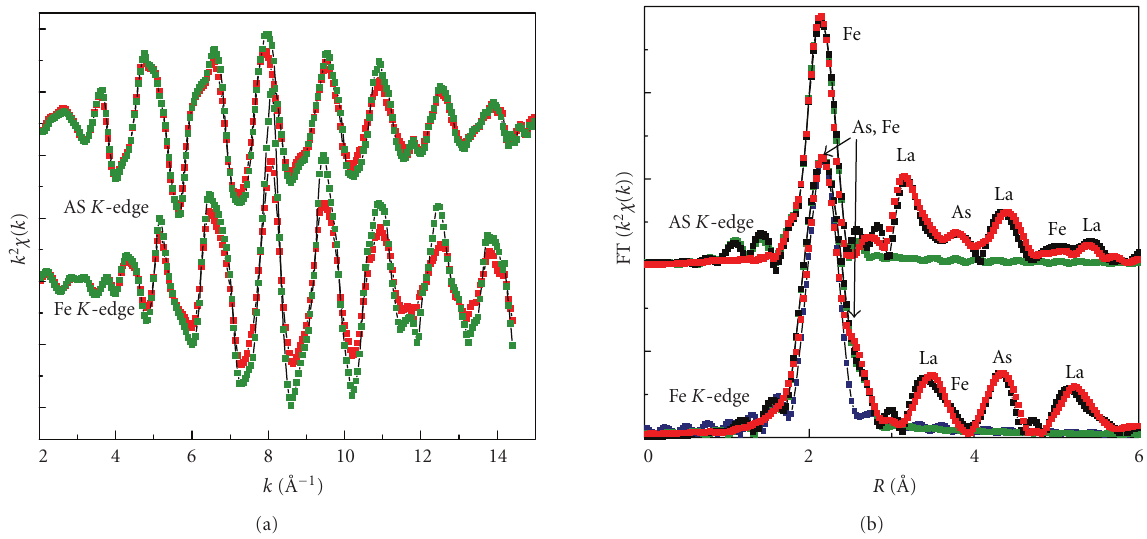
Figure 2: (a) The Fe K - and As K -edge EXAFS oscillations for LaFeAsO 1 − x F x ( x = 0 . 07) plotted as a function of photoelectron wave number k . Red and green marks indicate the data measured at 300 K and 10K, respectively, with a fluorescence detection mode. (b) Fourier transform magnitude functions for the same data. Red marks indicate the simulated (fitted) curve and black marks represent the experimental data. Green marks denote the experimental nearest neighbour contribution while blue marks represent theoretical calculation for the nearest neighbour Fe-As correlations, taken from